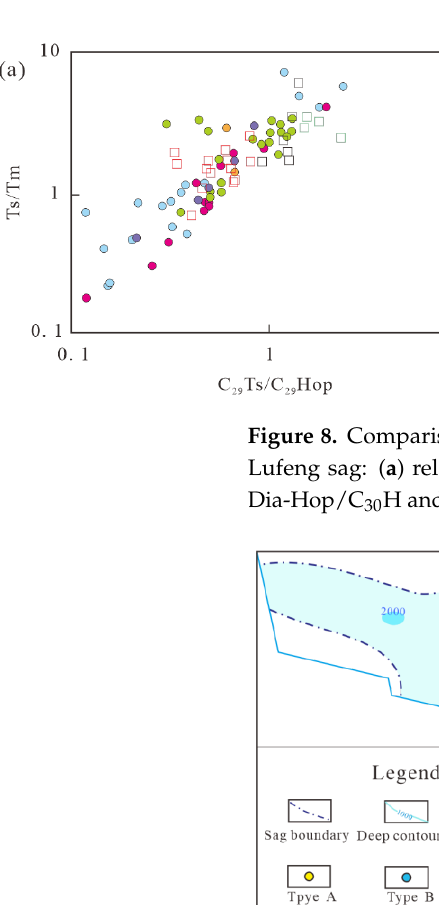
Figure 9. Oil and source rock correlation results for the WC in the southern Lufeng sag.